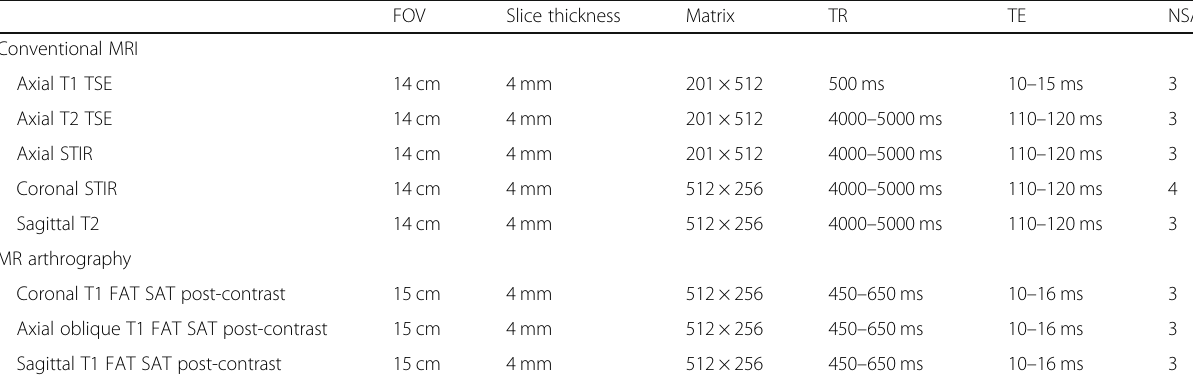
Table 1 Protocol of MRI